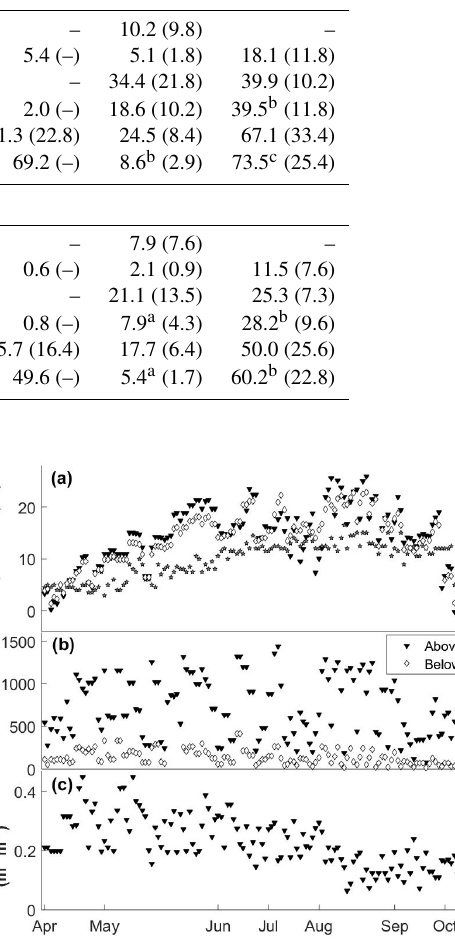
Figure 1. Environmental parameters during the measurements from 15 April to 23 October 2015. (a) Chamber, soil, and ambient temperature ( ◦ C). (b) Photosynthetically active radiation (PAR, µmolm − 2 s − 1 ) above and below the canopy. (c) Soil water content (m 3 m − 3 )